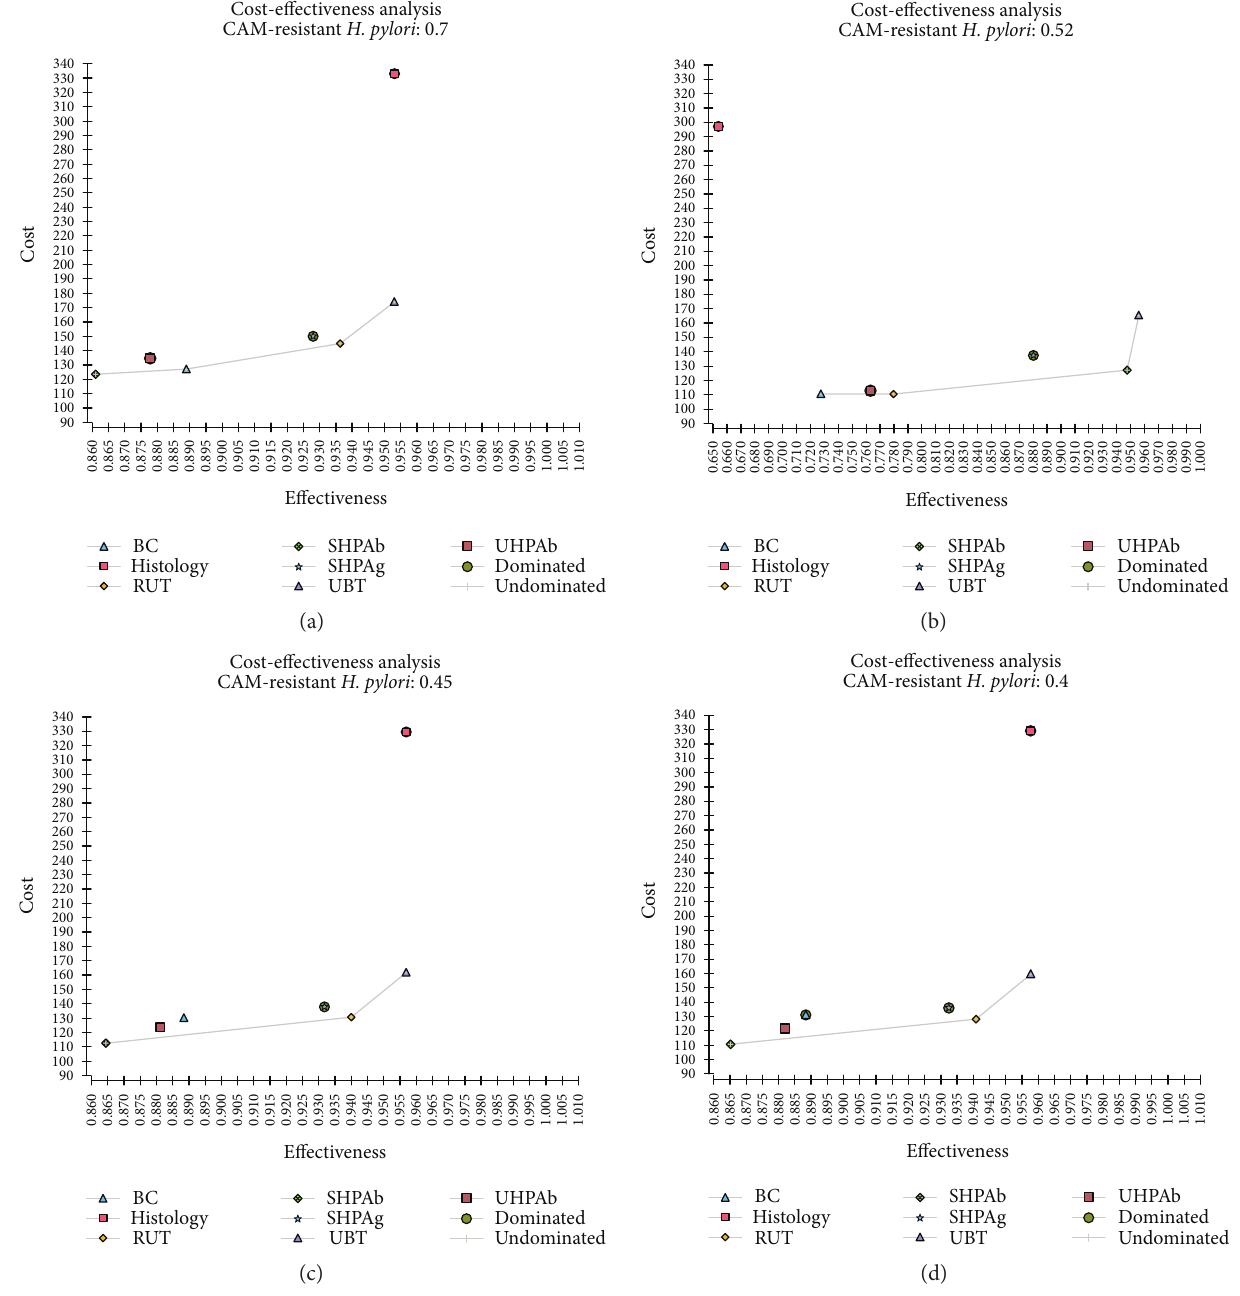
Figure 4: Cost-e ff ectiveness plane of sensitivity analysis. If the prevalence of clarithromycin- (CAM-) resistant H. pylori was ≥ 0.45 (a), bacterial culture (BC) with antibiotics susceptibility testing was not dominated. However, if the prevalence of CAM-resistant H. pylori was ≤ 0.44, BC was dominated by serum H. pylori IgG antibody, rapid urease test, and urea breath test (b – d). Table 2: Results of one-way sensitivity